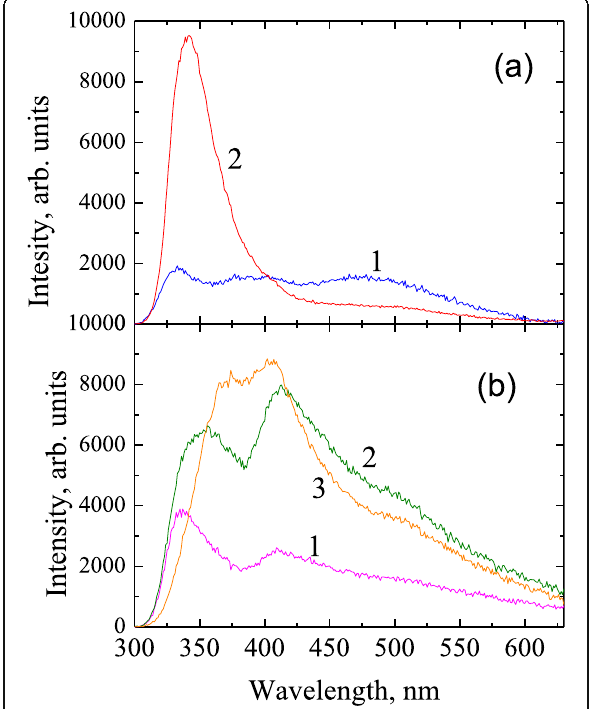
Fig. 3 PL spectra under 290 nm excitation. a Pristine fumed alumina ( 1 ) and phenyl-alumina before annealing ( 2 ). b Phenyl-alumina after annealing at 400 °C ( 1 ), 500 °C ( 2 ), and 600 °C ( 3